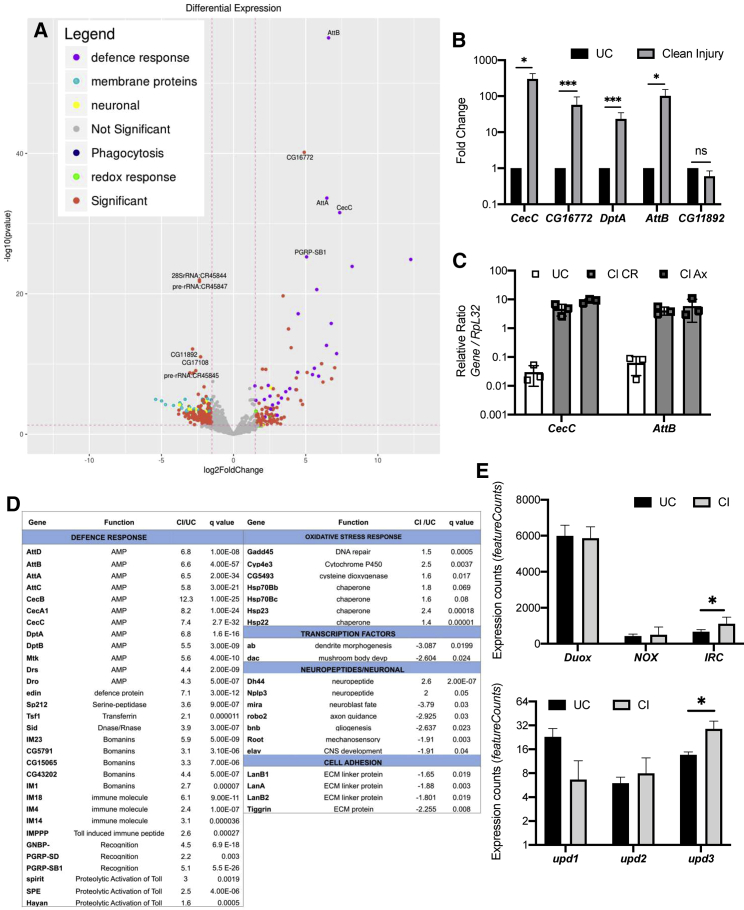
Defense Pathway Toll and Oxidative Stress Responses Are Induced upon Wounding in Hemocytes(A) A volcano plot showing genes significantly altered in hemocytes 1 h after injury. Log2 fold change values are plotted on the horizontal axis and −log10 of the p value on the vertical axis. Statistically significant regulated genes (p < 0.01) are shown in red, where GO categories are indicated (defense response, purple; membrane proteins, cyan; neuronal, yellow; redox, green; and phagocytosis, blue).(B) Validation of maximally differentially expressed genes from the RNA-seq data by qRT-PCR experiments in wild-type (w1118) hemocytes following injury. CecC, DptA, AttB, and CG16772 were found to be significantly upregulated by qRT-PCR. ∗∗∗p < 0.0001; ∗p < 0.05; ns, non-significant. Female flies were used for experiments.(C) qRT-PCR of the AMPs CecC and AttB expression in axenic flies in comparison with conventionally reared w1118 flies. UC, unchallenged; CI, clean injury.(D) Differentially regulated genes from the RNA-seq experiment according to their GO categories. Gene names, functions, fold change expression, and q-values are denoted for different GO categories, including the defense response.(E) Duox, NOX, and IRC gene expression (top) and upd-1, upd-2, and upd-3 gene expression (bottom) from the RNA-seq data in wild-type (w1118) hemocytes upon injury. IRC and upd-3 were found to be significantly upregulated. ∗p < 0.05, as determined by Student’s t test. Counts were normalized and extracted using the software featureCounts (PMID: 24227677). ± SD are shown in (B) and (C).